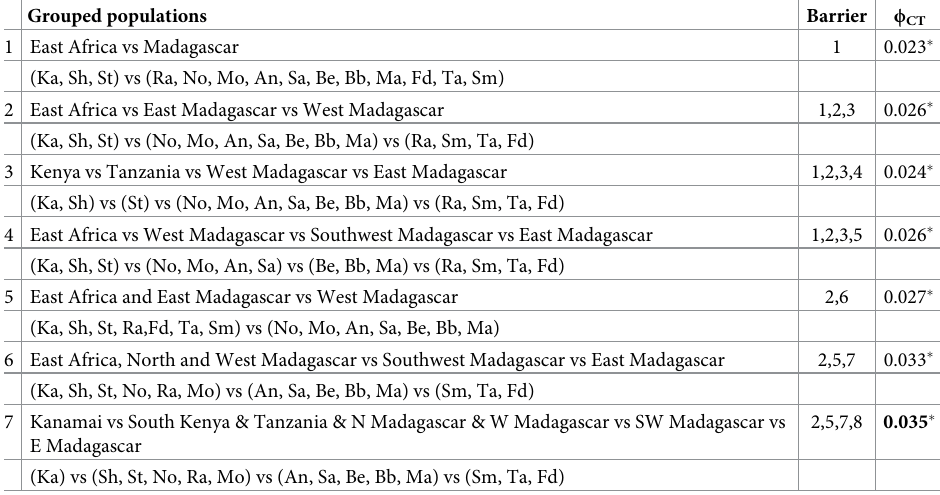
Table 2. Hierarchical AMOVA of O ctopus cyanea populations in the Western Indian Ocean. Grouped populations Barrier ϕ CT